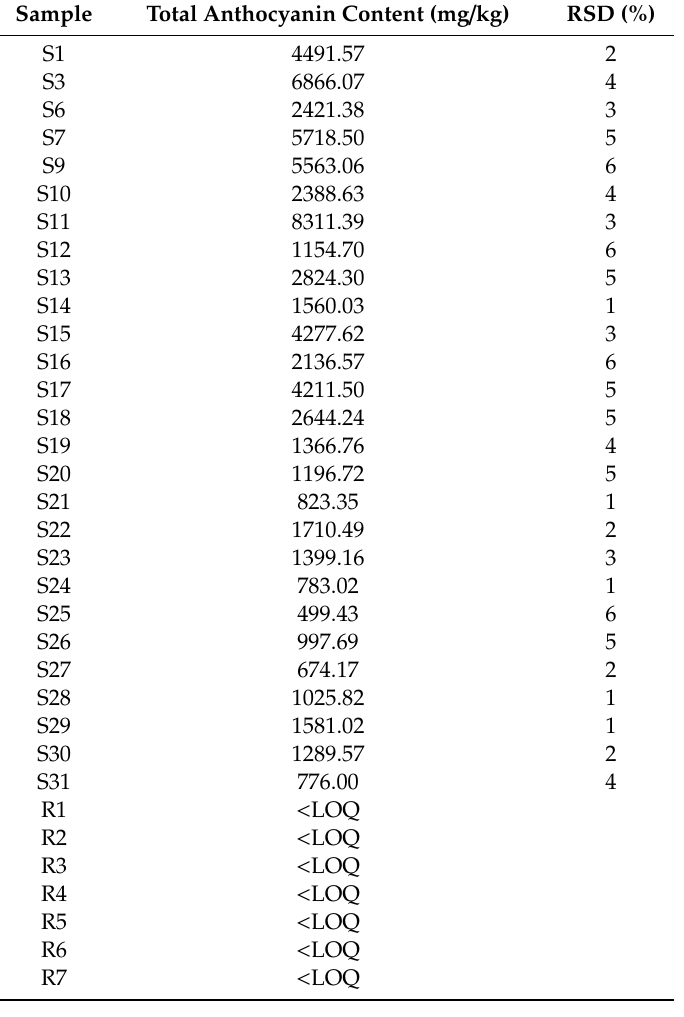
Table 3. Total anthocyanin content determined by UHPLC-MWD-UHR-TOF-MS